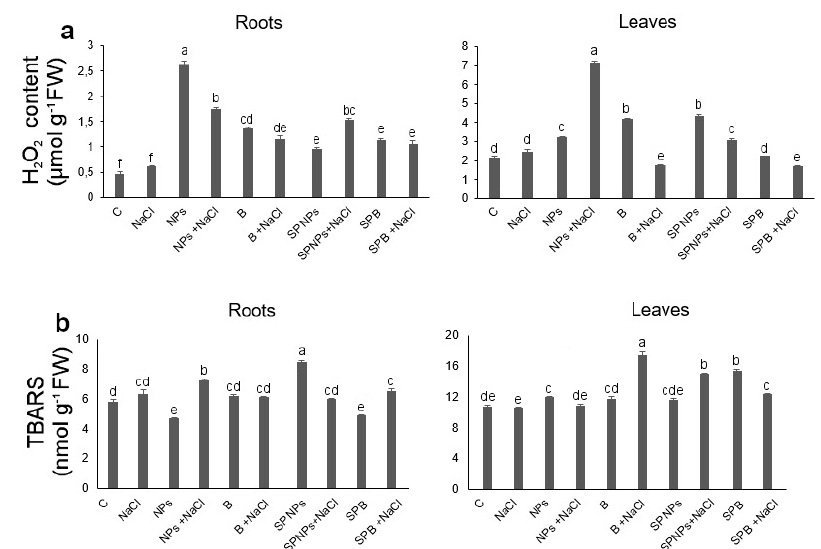
Figure 7. Hydrogen peroxide concentration ( a ) and thiobarbituric acid reactive substances (TBARS) concentration ( b ) in roots and leaves of T. turgidum L. ssp. durum cv. Cappelli without priming and salt treatment (C), with salt treatment without priming (NaCl), with ZnO treatment in the root zone (nanoparticles, NPs or bulk form, B), with ZnO priming in the root zone with salt treatment (NPs + NaCl or B + NaCl), with ZnO treatment as a leaf spray (SPNPs or SPB), and with ZnO priming as a leaf spray with salt treatment (SPNPs + NaCl or SPB + NaCl): values are means of at least four replicates ± SE. When ANOVA highlighted significant differences, Tukey’s post hoc test was performed, and different letters indicate significantly different mean values at p < 0.05.